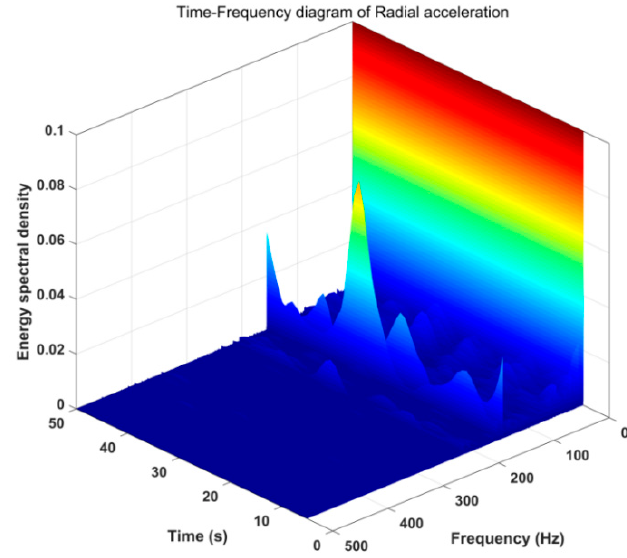
Figure 11. Time ‐ frequency diagram of radial acceleration of stick ‐ slip vibration. Figure 11. Time-frequency diagram of radial acceleration of stick-slip vibration.